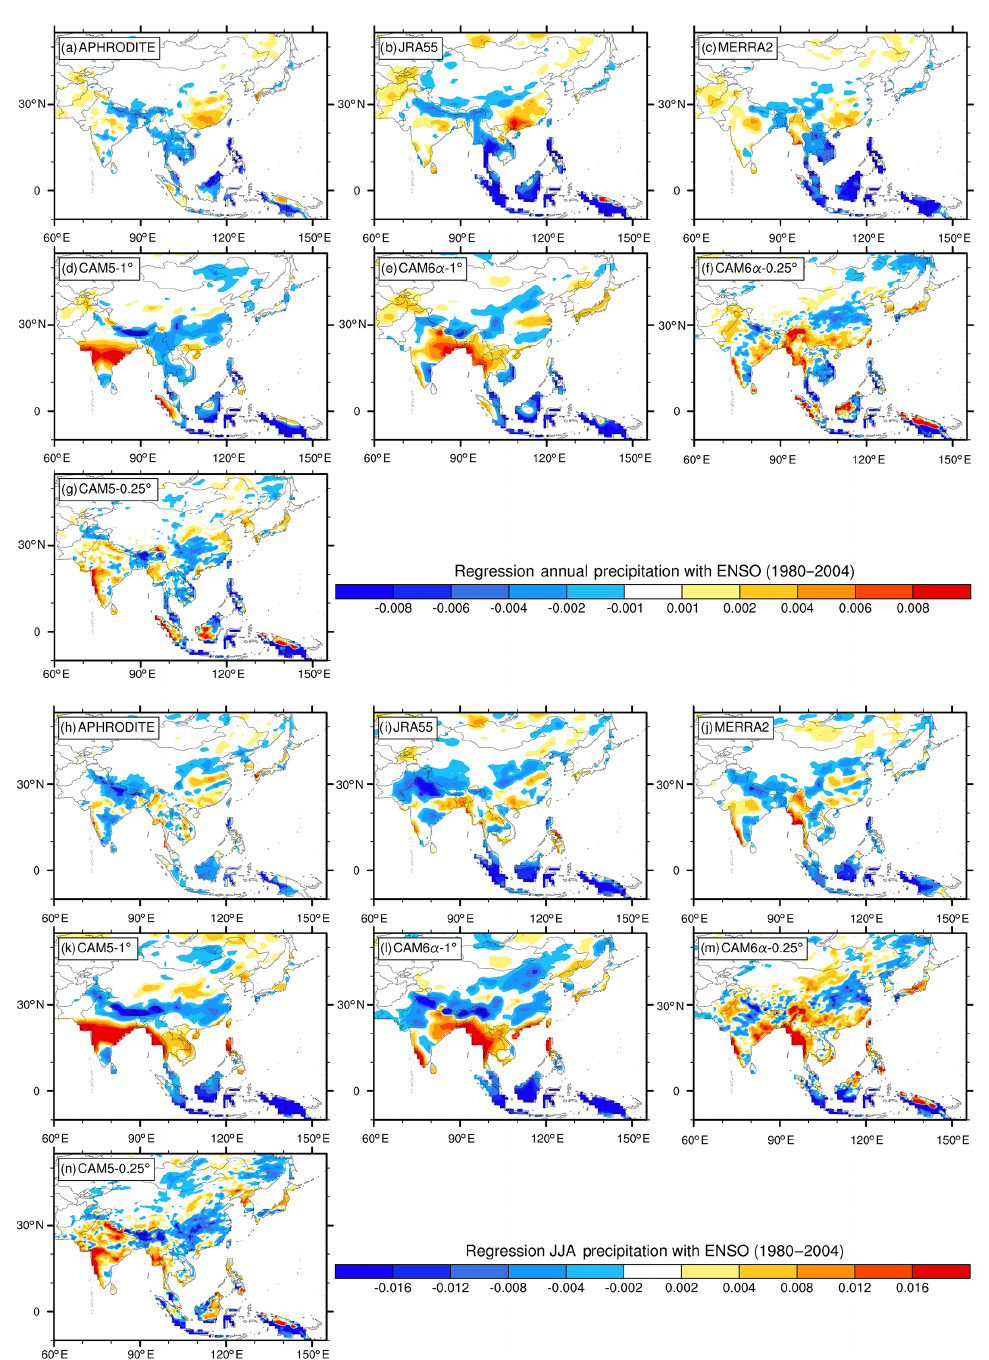
Figure 7. Regression of annual mean (a–g) and summer (JJA, h–n ) precipitation onto the observed ENSO index (mmd − 1 ) for 1980–2004. Top color bar is for panels (a–g) , bottom color bar is for panels (h–n)